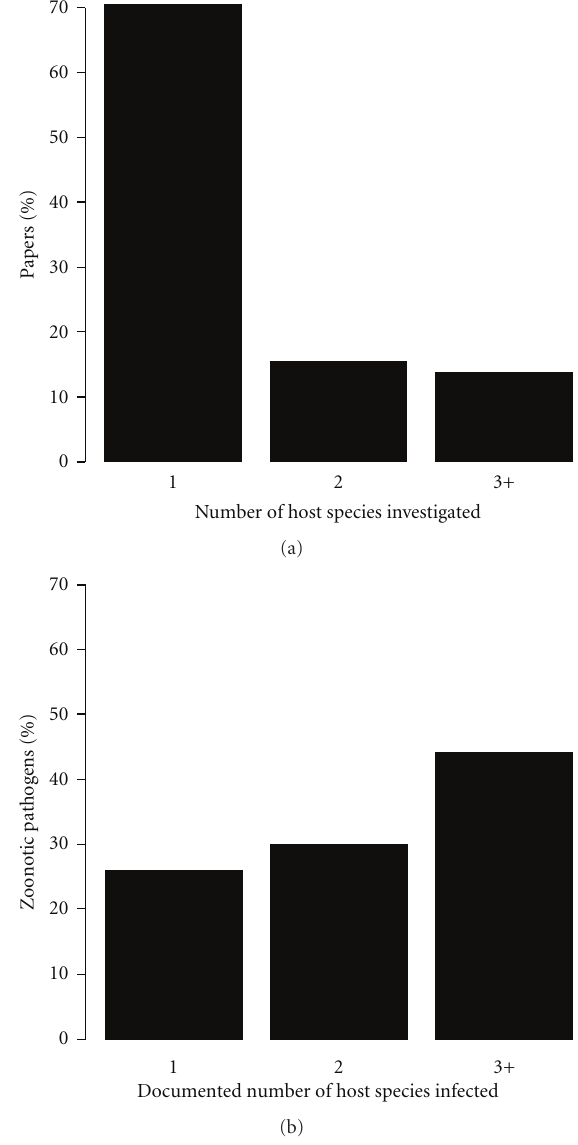
Figure 1: Although the vast majority of zoonotic disease scientific publications focus on a single vertebrate host species, the majority of zoonotic pathogens infect multiple host species. (a) Over 70% of the 1672 publications listed on PubMed that focus on a zoonotic pathogen investigated a single vertebrate host species. (b) By contrast, nearly 74% of the 865 zoonotic pathogens with documented host-species ranges infect multiple host species [1, 19–